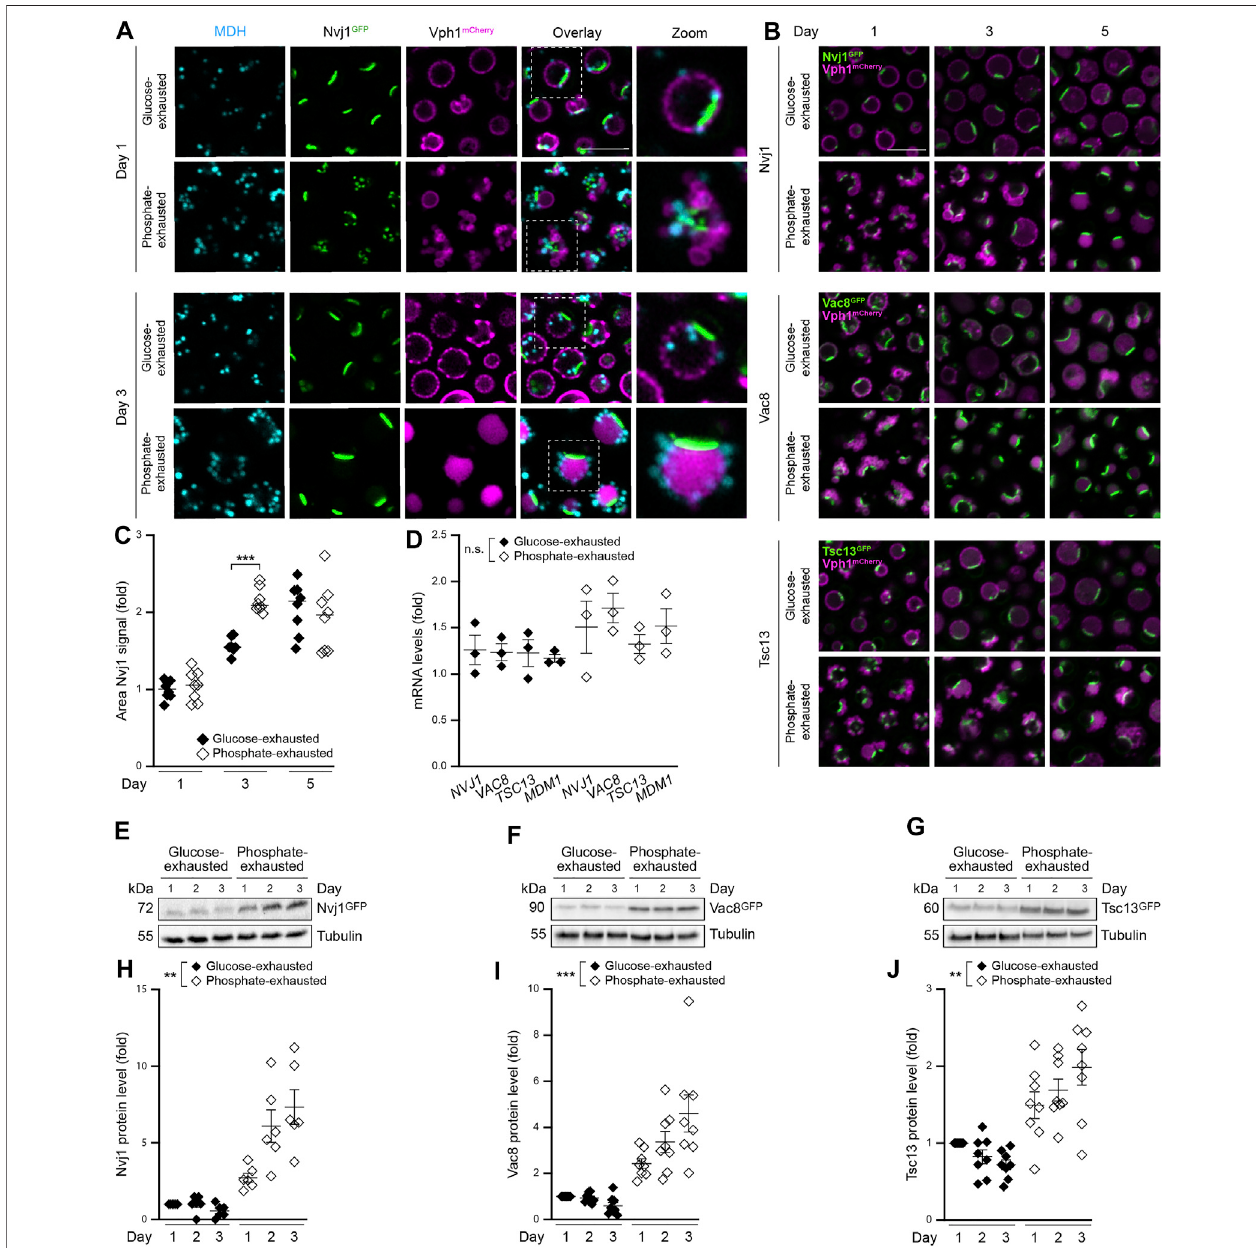
FIGURE 3 | Phosphate exhaustion results in rapid NVJ expansion and increased abundance of NVJ tether proteins (A) Confocal micrographs of WT (BY4741 unlessstated otherwise)cellsendogenouslyexpressingVph1 mCherry and Nvj1 GFP andstainedwithmonodansylpentane(MDH)tovisualizeLDs atday1and 3ofglucose or phosphate exhaustion. Scale bar: 5 μ m (B) Confocal micrographs of WT cells harboring endogenously GFP-tagged Nvj1, Vac8 or Tsc13 and simultaneously expressingVph1 mCherry tovisualizevacuolesatindicateddaysinglucoseorphosphateexhaustion.Scalebar:5 μ m (C) Automatedquanti fi cationofNvj1 GFP areain cellsshown in (B) ;Mean±SEM;n=8,withatleast150cellsperreplicateandtimepoint (D) RT-qPCR-basedquanti fi cationofmRNAlevelsof NVJ1,VAC8, TSC13 and MDM1 in WT (BY4742) cells at day 1 of glucose or phosphate exhaustion. Comparative CT method ( ΔΔ CT method) was used to calculate the relative gene expression using TAF10 ashousekeeping gene;Mean ±SEM; n=3 (E-J) Immunoblot analysis (E-G) and corresponding densitometricquanti fi cation (H-J) ofprotein extracts from WT cells subjected to glucose or phosphate exhaustion and endogenously expressing the GFP-tagged NVJ-resident proteins Nvj1 GFP (E, H) , Vac8 GFP (F, I) and Tsc13 GFP , (G, J) . Values were normalized to tubulin as loading control and are depicted as fold of respective glucose-exhausted cells at day 1; Mean ± SEM; n = 6 (for Nvj1 GFP ) or n = 8 (for Vac8 GFP and Tsc13 GFP ). For more details in respect to statistical analyses, please see Supplementary Table S4 .